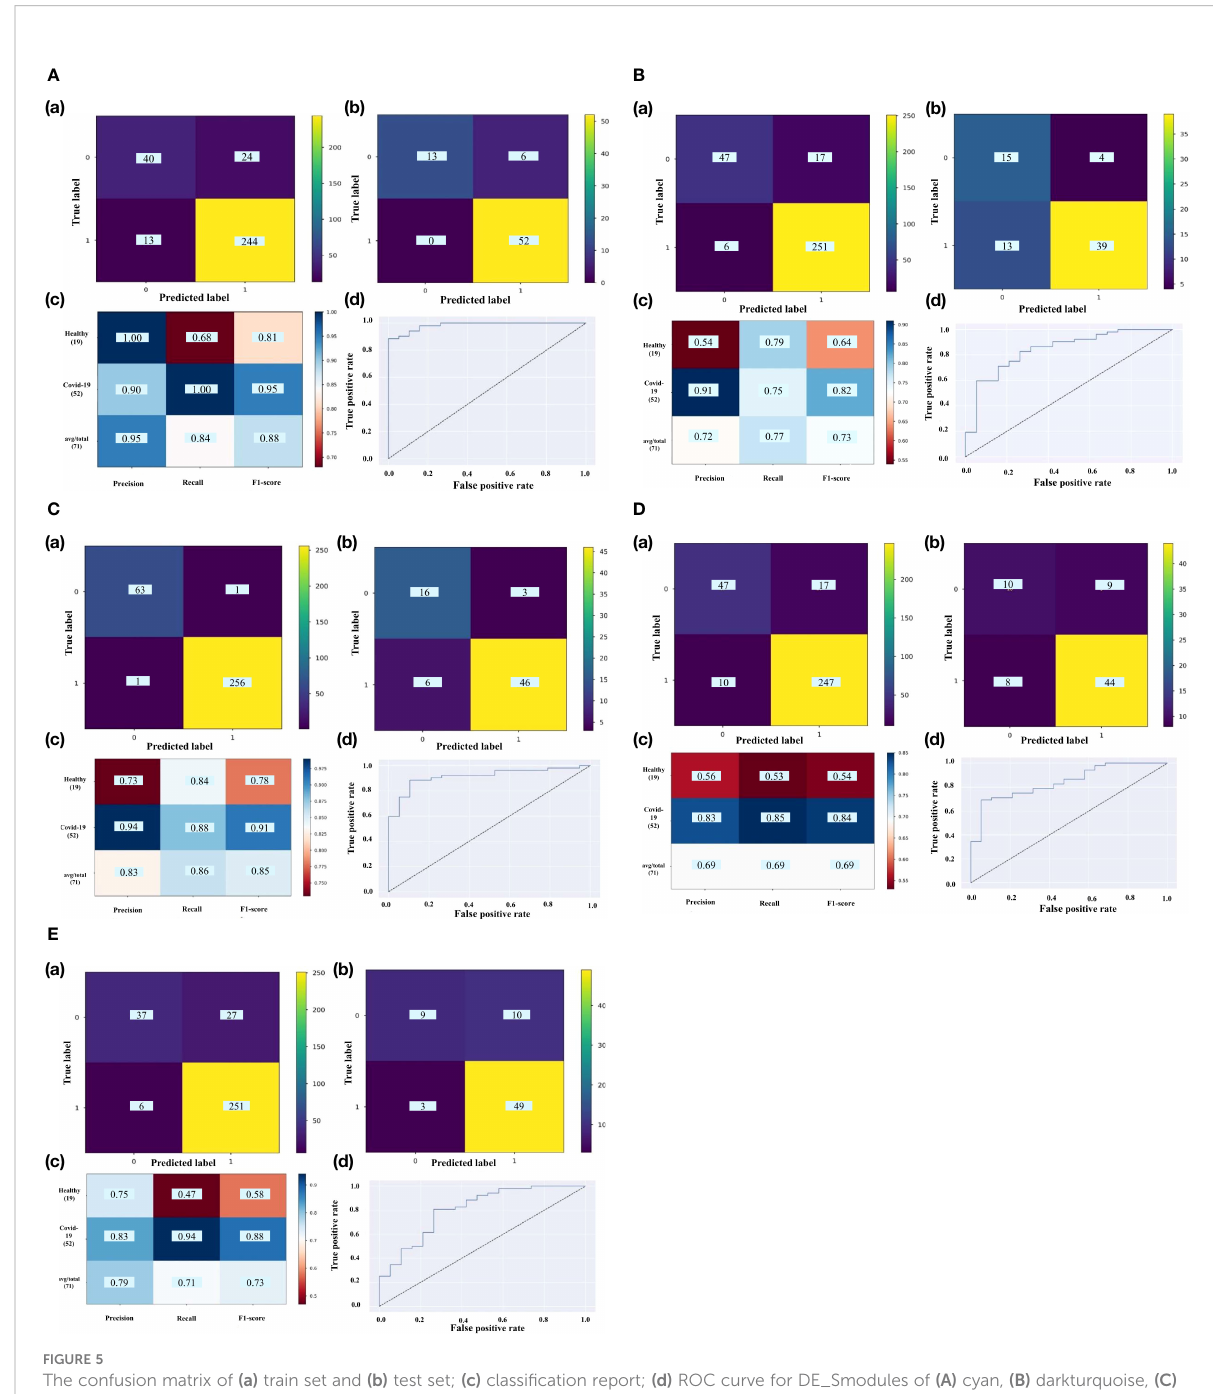
FIGURE 5 The confusion matrix of (a) train set and (b) test set; (c) classi fi cation report; (d) ROC curve for DE_Smodules of (A) cyan, (B) darkturquoise, (C) lightyellow, (D) midnightblue, (E) orange. The confusion matrix shows the number of true and predicted label in healthy (label 0) and